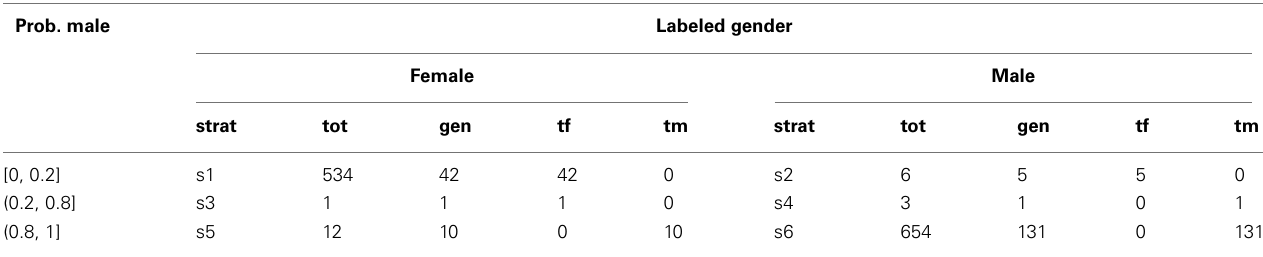
Table 1 | Stratum labels (strat), numbers within each stratum (tot), numbers within strata of known true gender (gen) and true gender counts (tf = true female, tm = true male, tf + tm = gen). Prob.